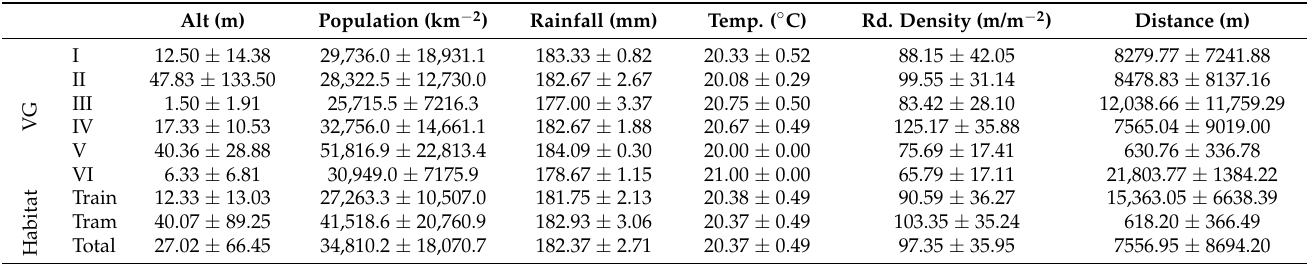
Table 3. Mean ± standard deviation of the environmental characteristics in relation to habitats and 6 vegetation groups derived after application of TWINSPAN. The vegetation groups are I: Urospermum picroides , II: Chenopodium murale , III: Malva parviflora , IV: Cynodon dactylon , V: Hordeum leporinum , and VI: Sonchus oleraceus